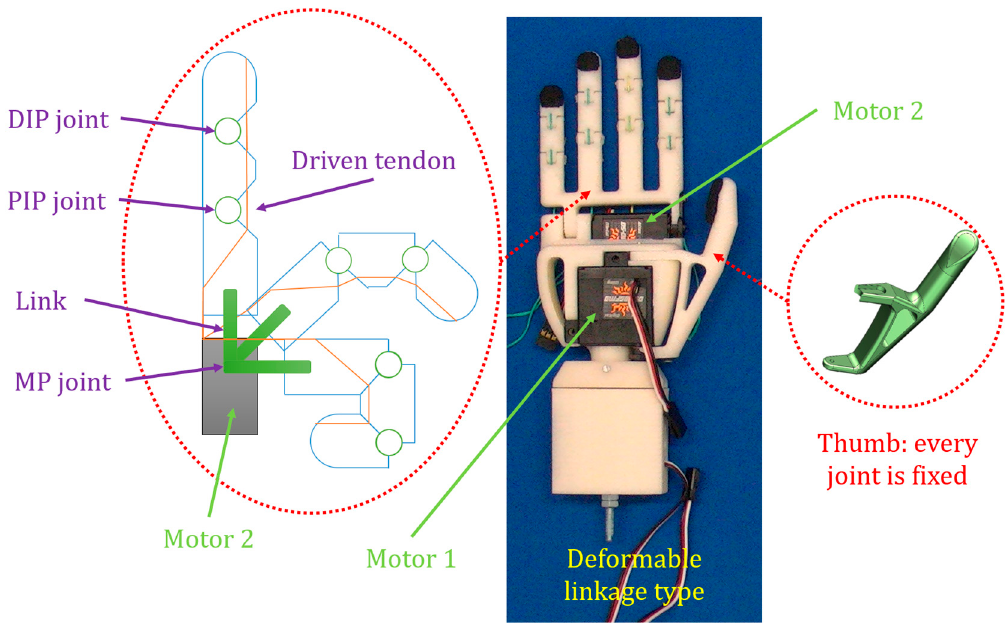
Figure 18. Adaptive linkage type: the assembled hand, part of the thumb, and tendon-driven mechanism of the four fingers.